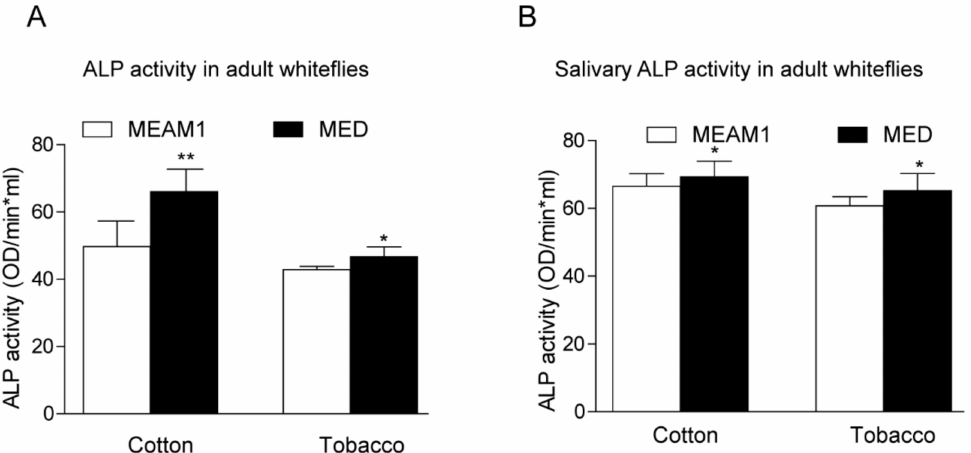
Figure 5. ALP activity analysis in whole insects ( A ) and whiteflies’ saliva ( B ) after feeding on different hosts. * indicates p < 0.05, ** p <